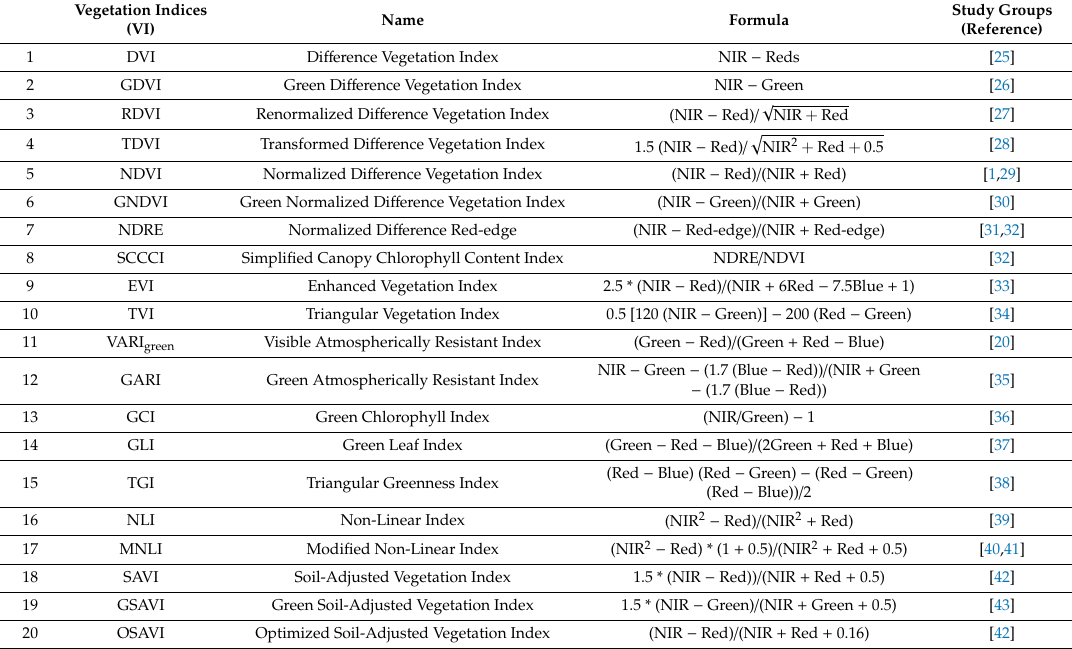
Table 1. Mathematical representation of vegetation indices and ratios calculated from spectral